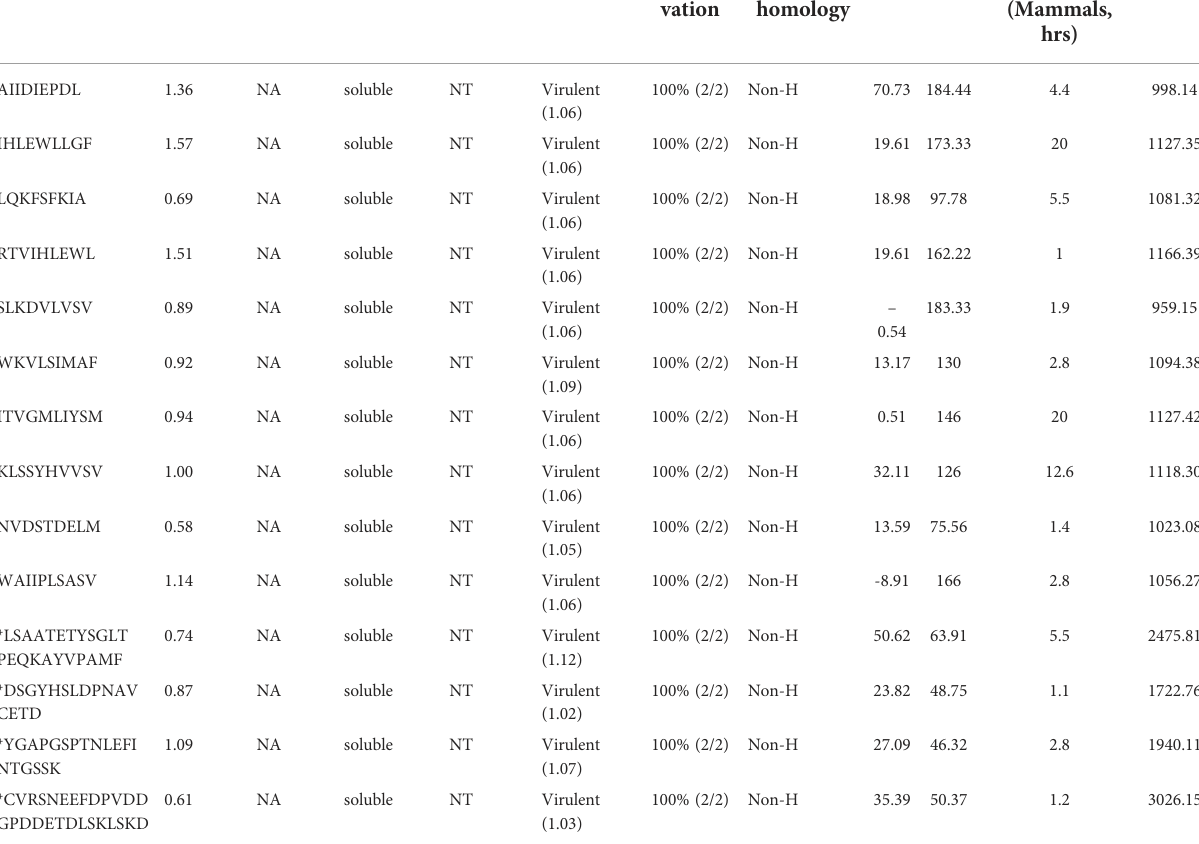
TABLE 1 Sequence conservation, human homology, immunological and physicochemical properties of fi nalized experimentally validated epitopes of MPXV. Epitopes AT Allergenicity Solubility Toxicity Virulence Conser-